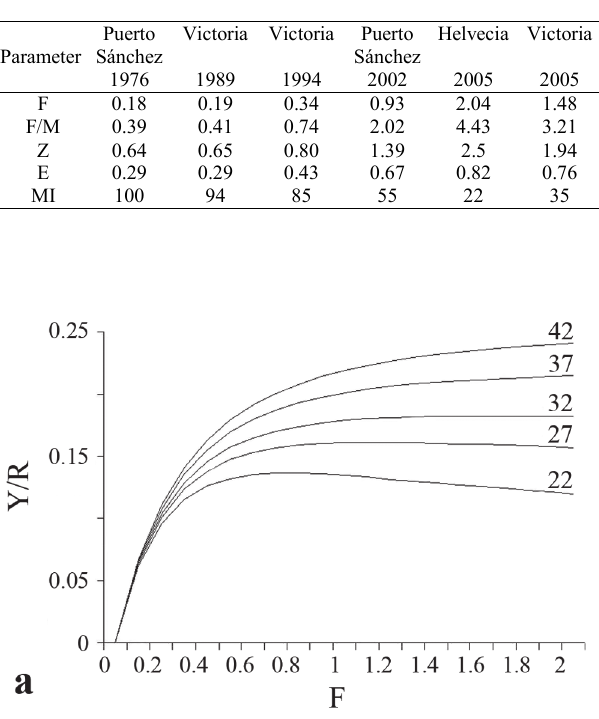
Table 1. Fishing mortality (F), fishing mortality-natural mortality ratio (F/M), total mortality (Z), exploitation ratio (E) and megaspawner index (MI) estimated for different fishery years in analyzed landing sites.